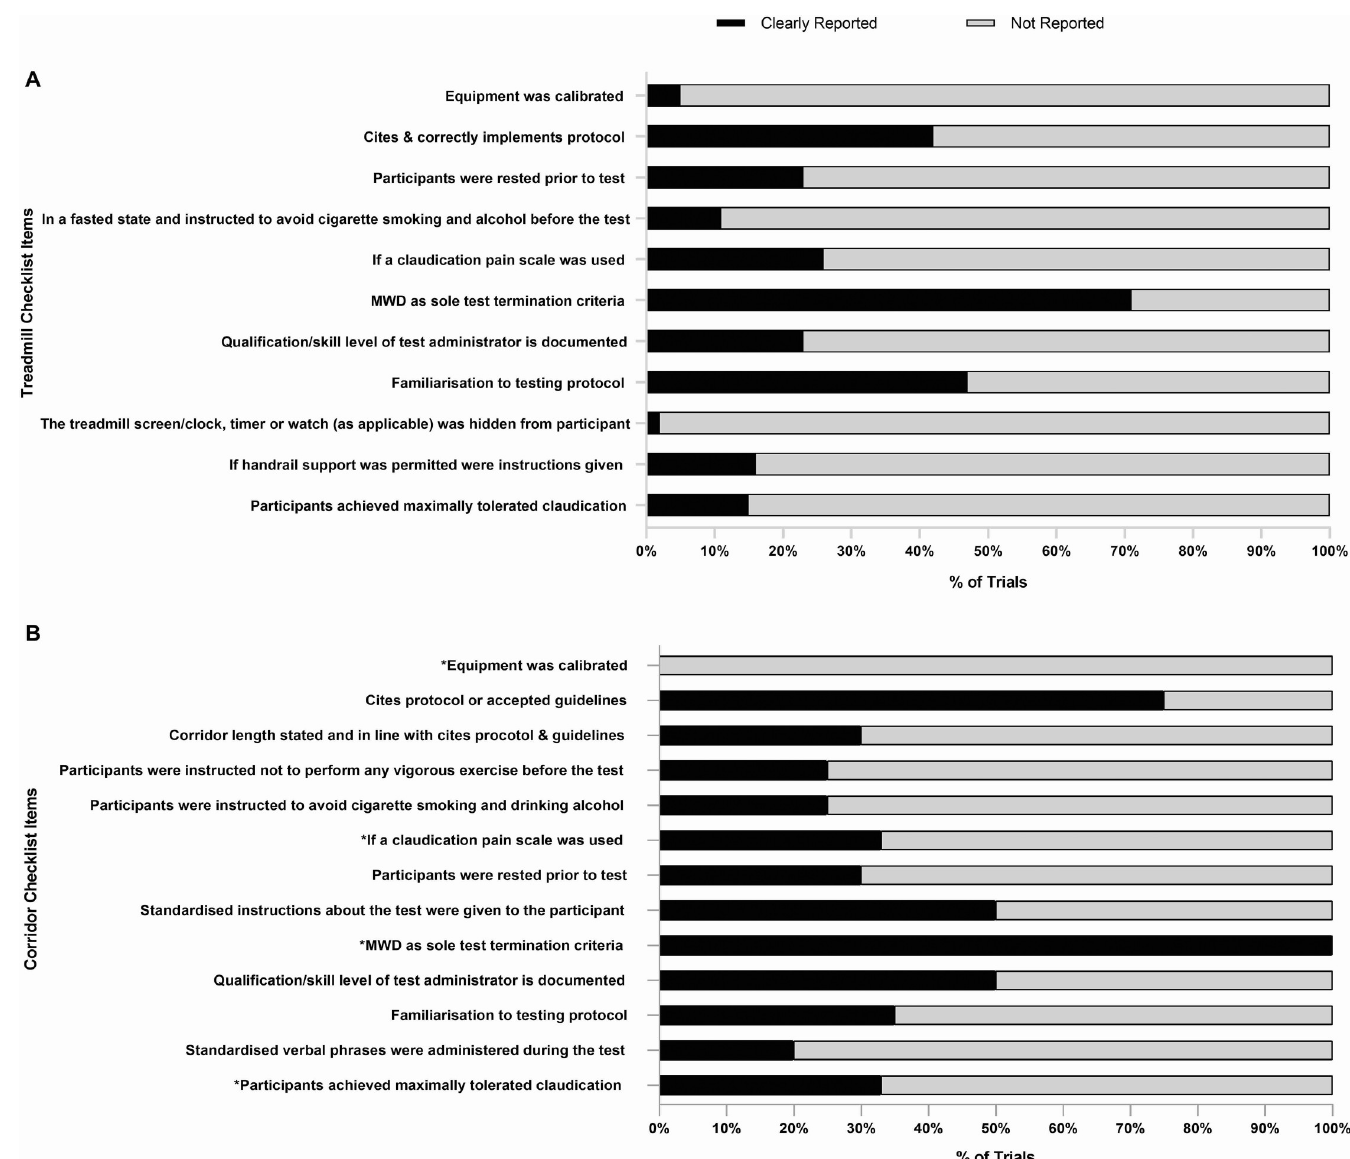
Fig 2. The percentage of trials that reported the treadmill and corridor testing criteria. MWD, maximal walking distance.